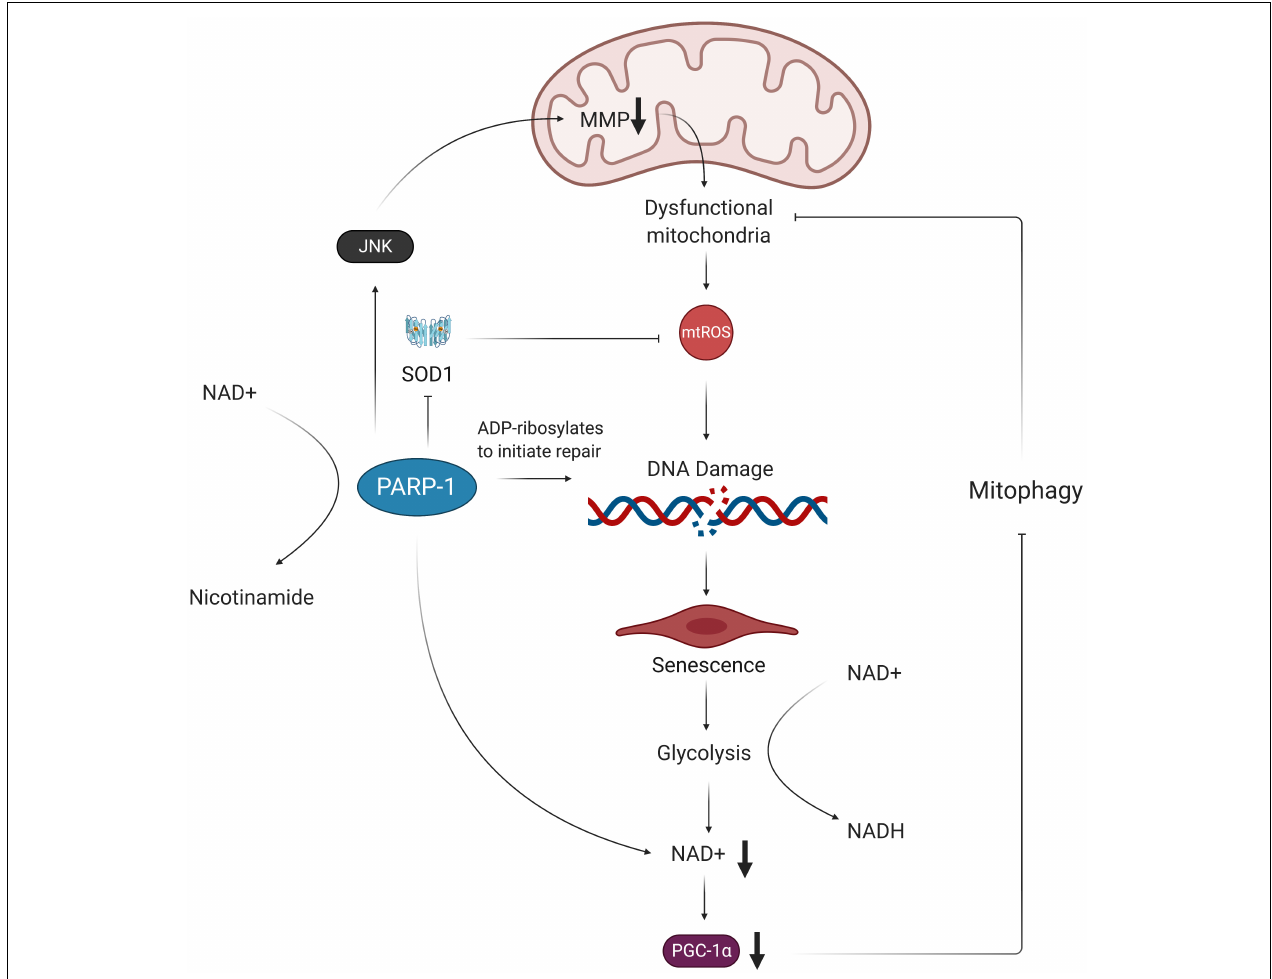
FIGURE 4 | Oxidative stress results in NAD+ depletion and perpetuates mitochondrial dysfunction. Oxidative damage of telomeric DNA invokes the PARP-1 DNA damage response, which consumes NAD+ in order to ADP-ribosylate DNA and proteins. This activation of PARP-1 exacerbates accumulation of mtROS by decreasing expression of SOD1 and decreasing MMP. The excess mtROS also induce senescence via oxidative telomere damage, which leads to a metabolic shift toward glycolysis. This increased glycolytic activity results in further NAD+ depletion in ECs, which, in turn, leads to decreased expression of PGC-1 α . Without PGC-1 α to promote expression of mitophagy-related genes, the dysfunctional mitochondria are not properly removed from the cell and are thus able to continue producing more mtROS, contributing to a chronic state of oxidative stress in ECs. MMP, mitochondrial membrane potential; mtROS, mitochondrial reactive